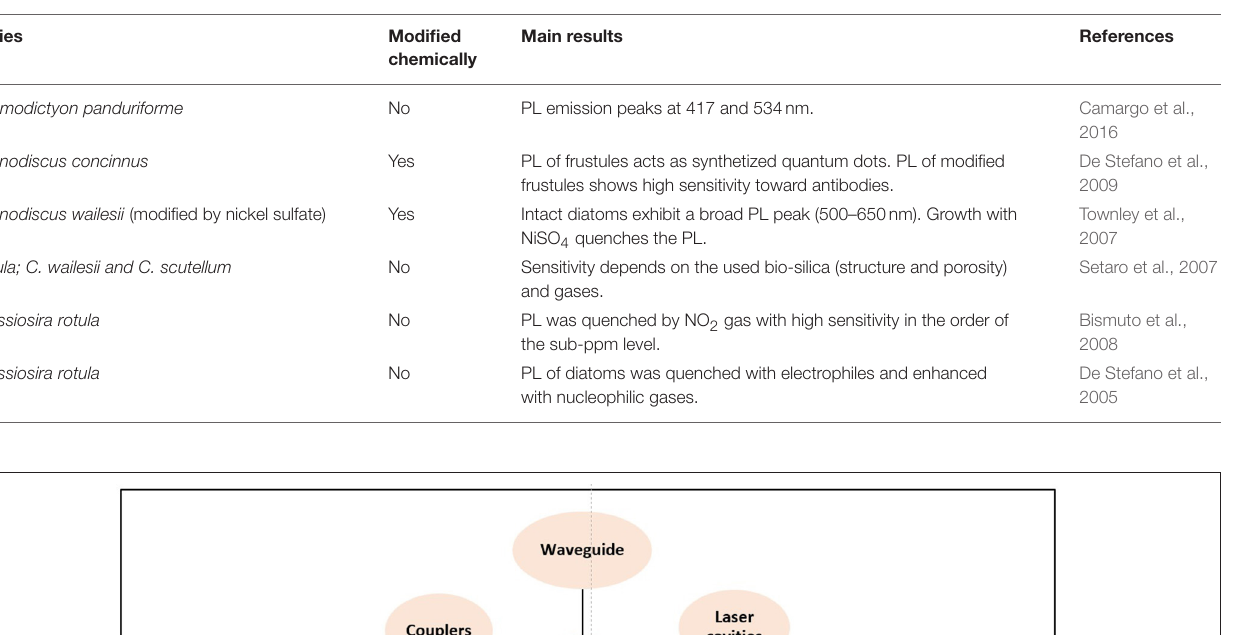
cell printing as promising materials for regenerative medicine.